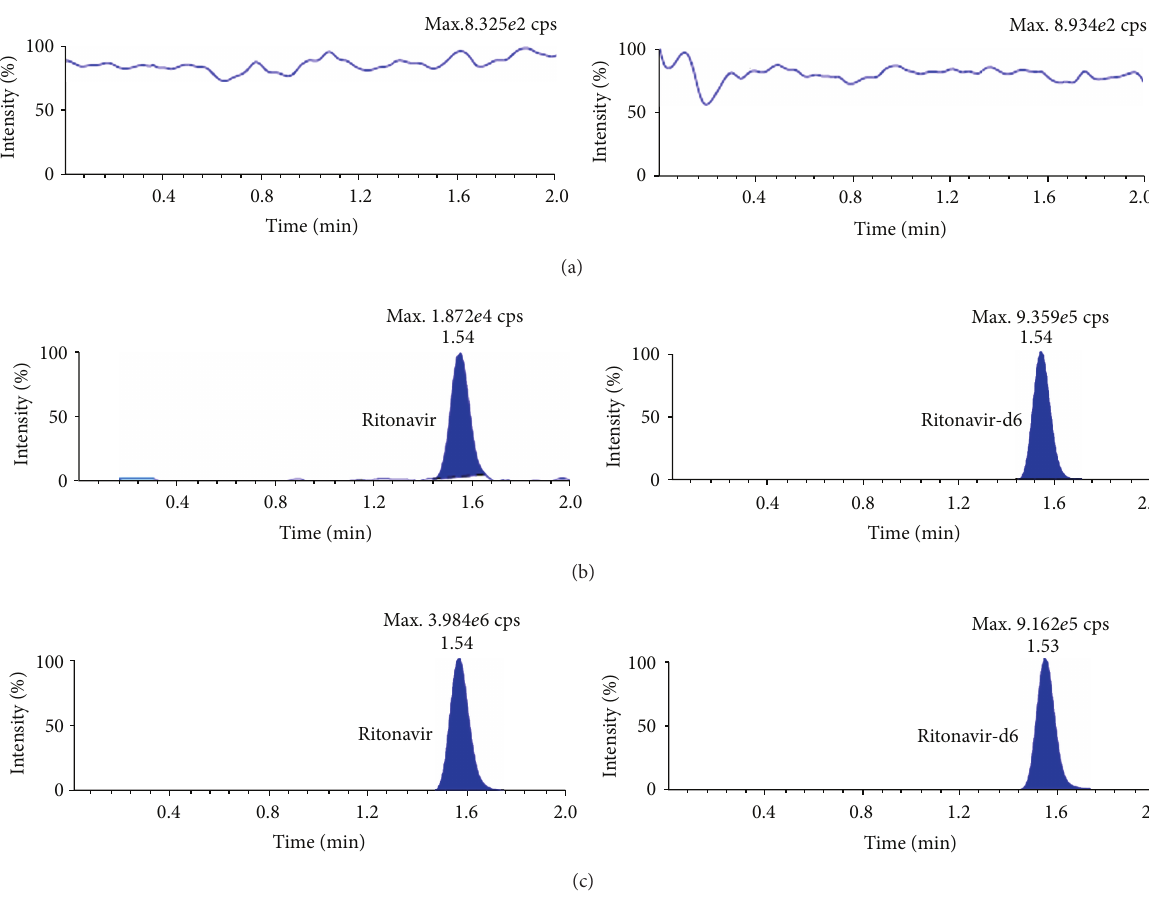
Figure 5: MRM ion chromatograms of ritonavir in (a) double blank plasma (without analyte and IS), (b) at LLOQ and ritonavir-d6, and (c) in real subject